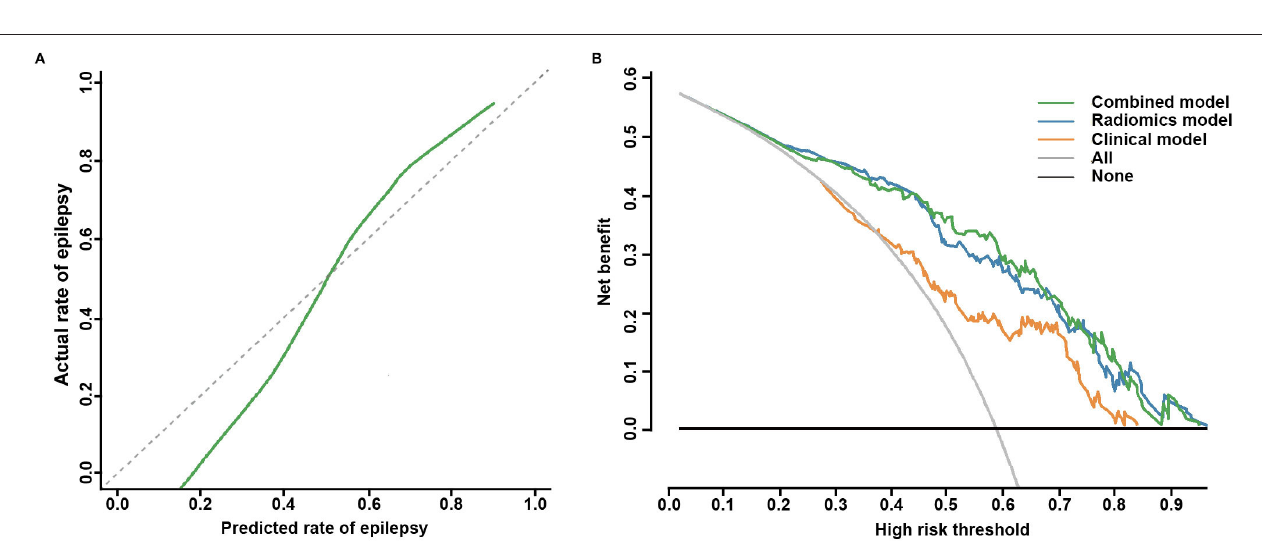
FIGURE 4 | Calibration curve for the nomogram and decision curve analysis for the three models. (A) The calibration curve indicates the goodness-of-fit of the nomogram. The 45 ◦ gray dotted line represents the ideal prediction, and the green curve represents the predictive performance of the nomogram. The closer the green curve is to the ideal prediction line, the better the predictive efficacy of the nomogram. (B) Decision curve analysis of the three models in the whole cohort. The green curve, the blue curve, and the orange curve represent the net benefits of the combined model, the radiomics model, and the clinical model, respectively. The combined model had a higher net benefit than the other two models and simple diagnoses, such as all epilepsy patients (gray curve) or no epilepsy patients (black curve), across a large range of threshold probabilities at which a patient would be diagnosed with epilepsy.